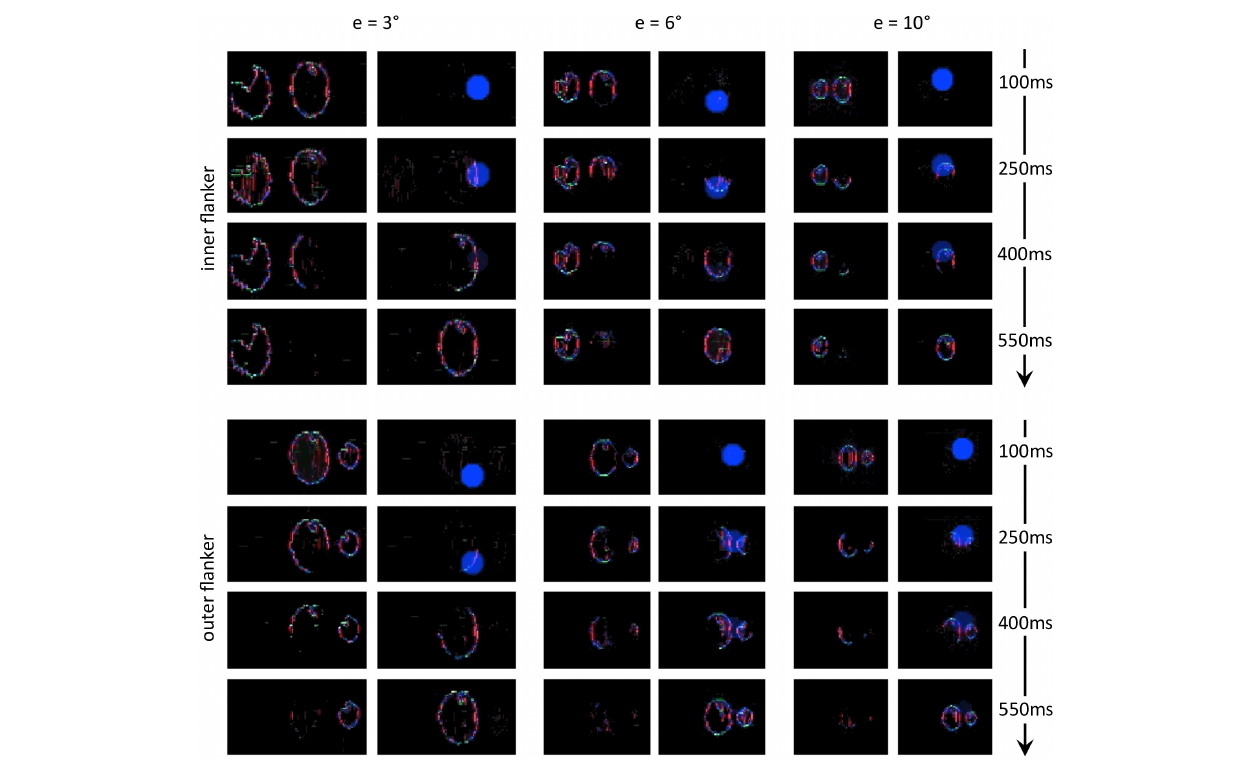
FIGURE 14 | Characteristic examples of segmentation processes for all conditions of experiment 5 of Farzin et al. (2009; see Figures 3B–C ). The output of the segmentation model has the same scale across the conditions (e.g., the selection signals always have the same size). For both conditions at 3 ◦ of eccentricity, the retina model represents the stimulus with such details, that the task is easy even for an outer flanker, resulting in a high rate of segmentation success across the trials, and no substantial difference of threshold between those conditions. For larger eccentricities, the whole stimulus representation has a lower resolution. The target appears smaller, and the flankers appear closer to the target. Many trials thus lead to unsuccessful segmentation, because the selection signals have only a very small region to select only one of the objects. At the same time, the inner flanker is always better represented than the outer flanker. The model thus generates differences of thresholds between the inner-flanker and the outer-flanker